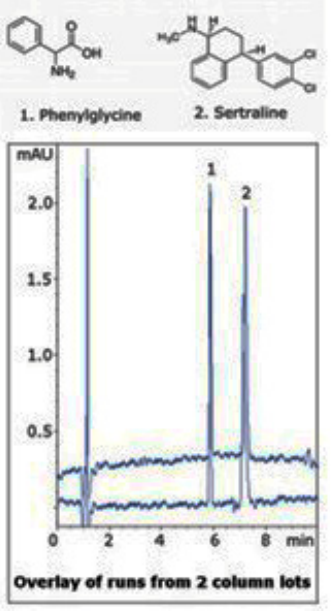
Figure 6. Separation of a polar and nonpolar compound in a single run on a silica hydride-based (Diamond Hydride) HPLC column. Mobile phase: A, DI water + 0.1% formic acid and B acetonitrile + 0.1% formic acid. Gradient: 0–1 min 95%B, 1–6 min to 50% B. (http://kb.mtc-usa.com/article/AA-01460/0/).